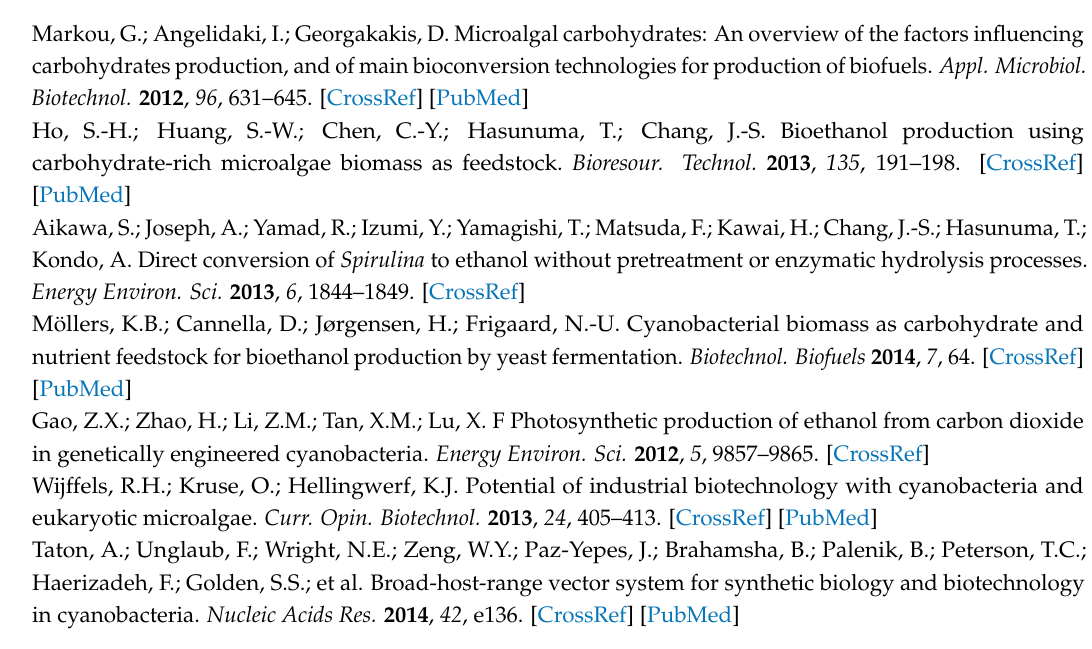
Figure S1: The Venn diagrams illustrate the overlapped genes among RAST [24], KAAS [26], and i AK692 [23]. Figure S2: Heat map of the confidence score of each pathway in i AK888. The columns represent the level of confidence score (ranging from 1 to 4) and the rows represent the metabolic pathway. The various colors correspond to the percentage of pathway reactions that have the corresponding confidence score (orange = 100%, blue = 0%). Based on the confidence score system [37], 4 represents physiological and genetic evidence, 3 represents direct and indirect evidence for gene function, 2 represents indirect evidence from physiological data or only sequence-based evidence, and 1 represents modeling evidence. Supplementary File S1: Biomass composition of A. platensis C1. Supplementary File S2: Genome annotation. Supplementary File S3: Detailed GPR information of model i AK888. Supplementary File S4: SBML of autotrophic growth photon uptake 100 µ mol photons/m 2 /s. Supplementary File S5: SBML of autotrophic growth photon uptake 200 µ mol photons/m 2 /s.